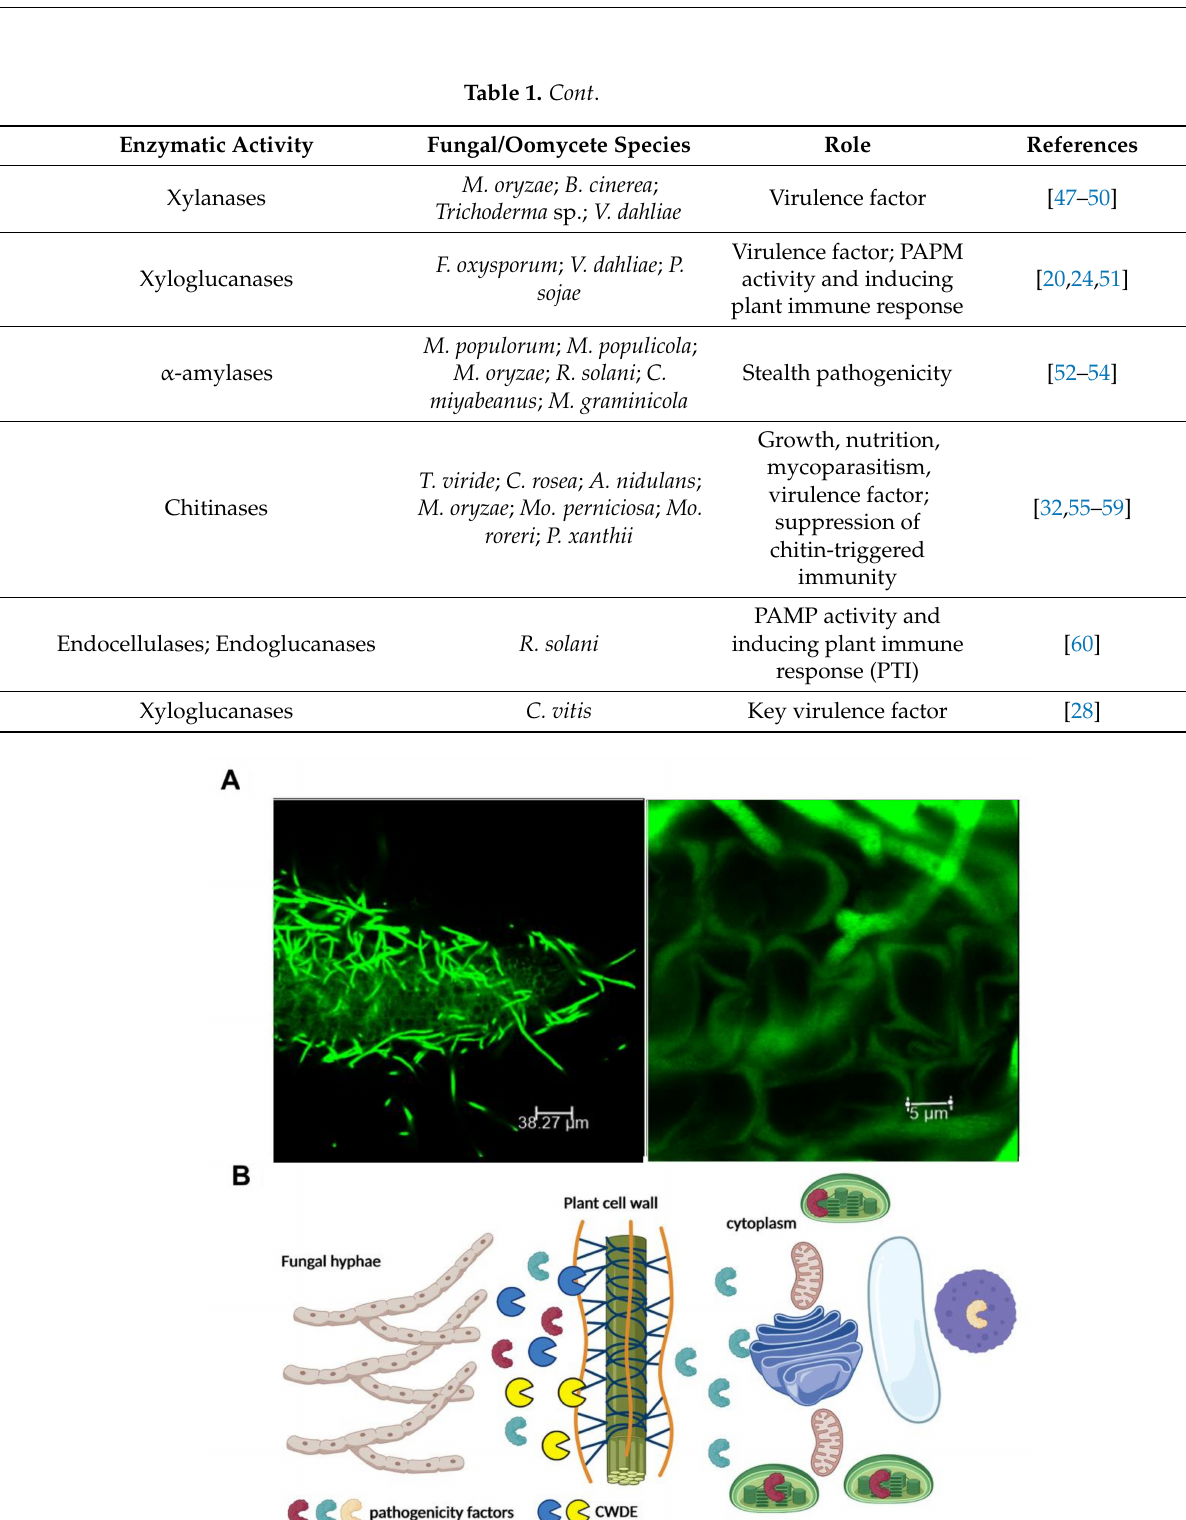
Figure 2. CWDEs are involved in host plant colonization. ( A ) Confocal scanning microscopy of Arabidopsis thaliana roots infected with the soil-borne pathogen, Verticillium longisporum , expressing the green fluorescent protein. To avoid recognition and successfully colonize its host, V. longisporum produces small secreted proteins as well as a repertoire of carbohydrate-active enzymes to degrade plant material [34]. Photo by Dr. Panagiotis Moschou (https://pmoschoulab.wordpress.com/home/, accessed on 10 March 2021). Used with permission. ( B ) Schematic representation of the role of CWDEs in the establishment of a successful infection. Fungi secrete CDWEs in order to facilitate the penetration of pathogenicity factors to the plant cytoplasm. The figure was created by BioRender